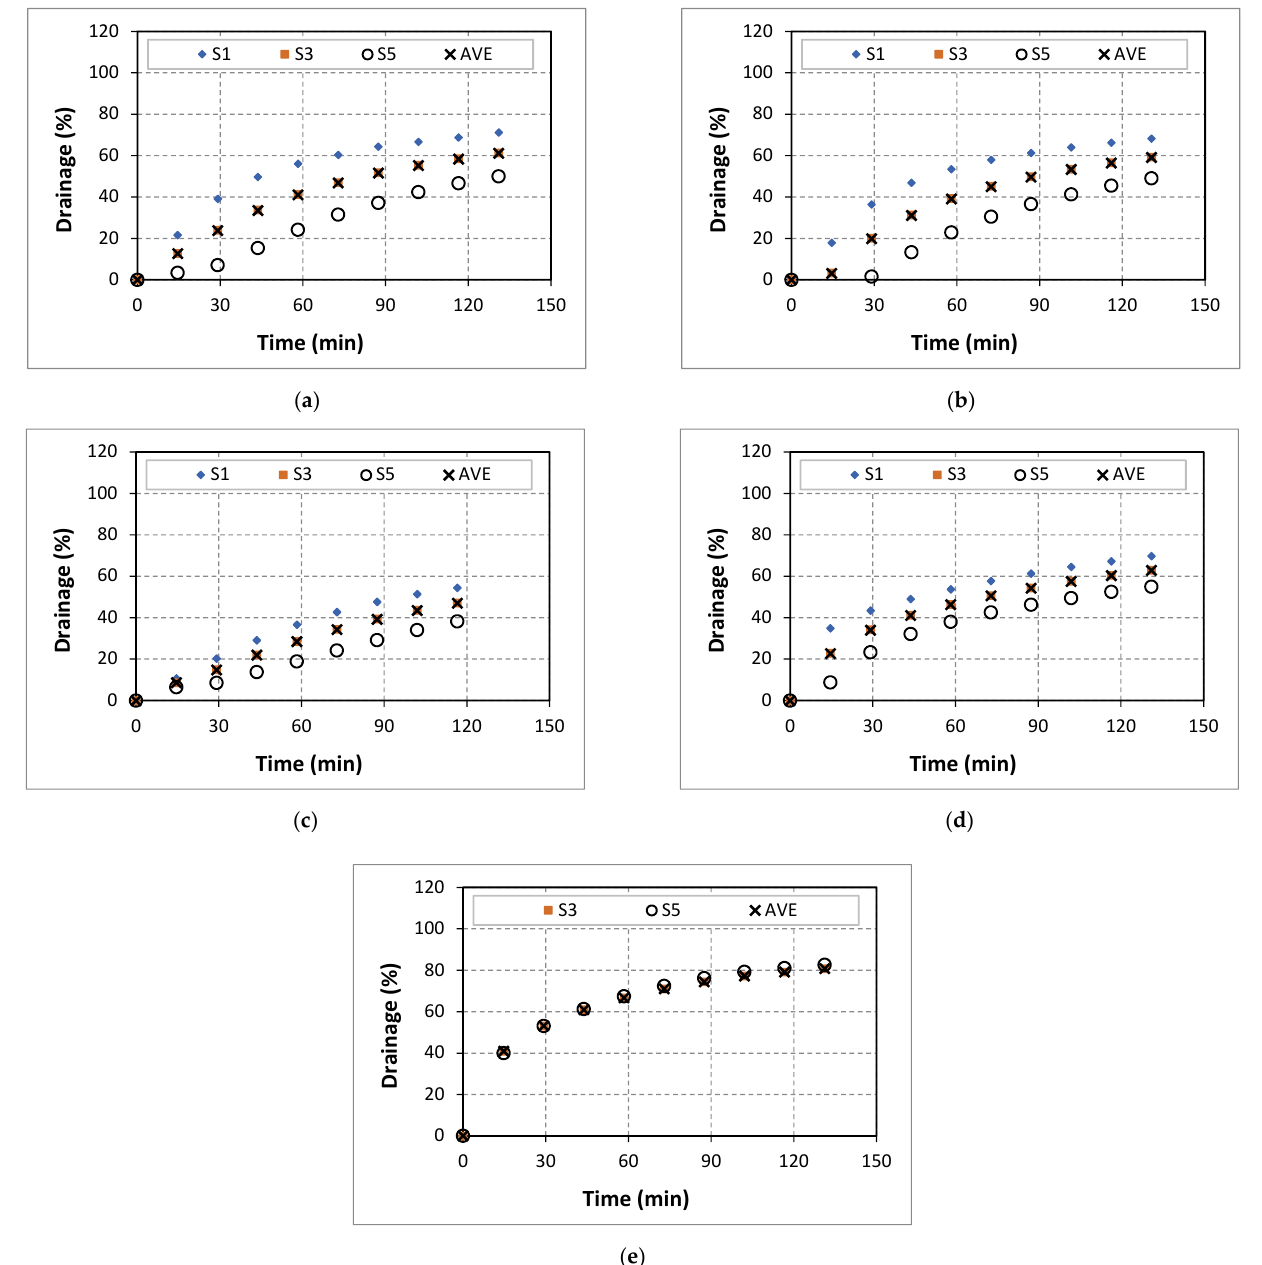
Figure 9. Drainage of 40% quality aqueous foam at different CaCl 2 concentrations: ( a ) 0% wt., ( b ) 5% wt., ( c ) 7% wt., ( d ) 9% wt., ( e ) 14% wt., and ( f ) 18% wt.